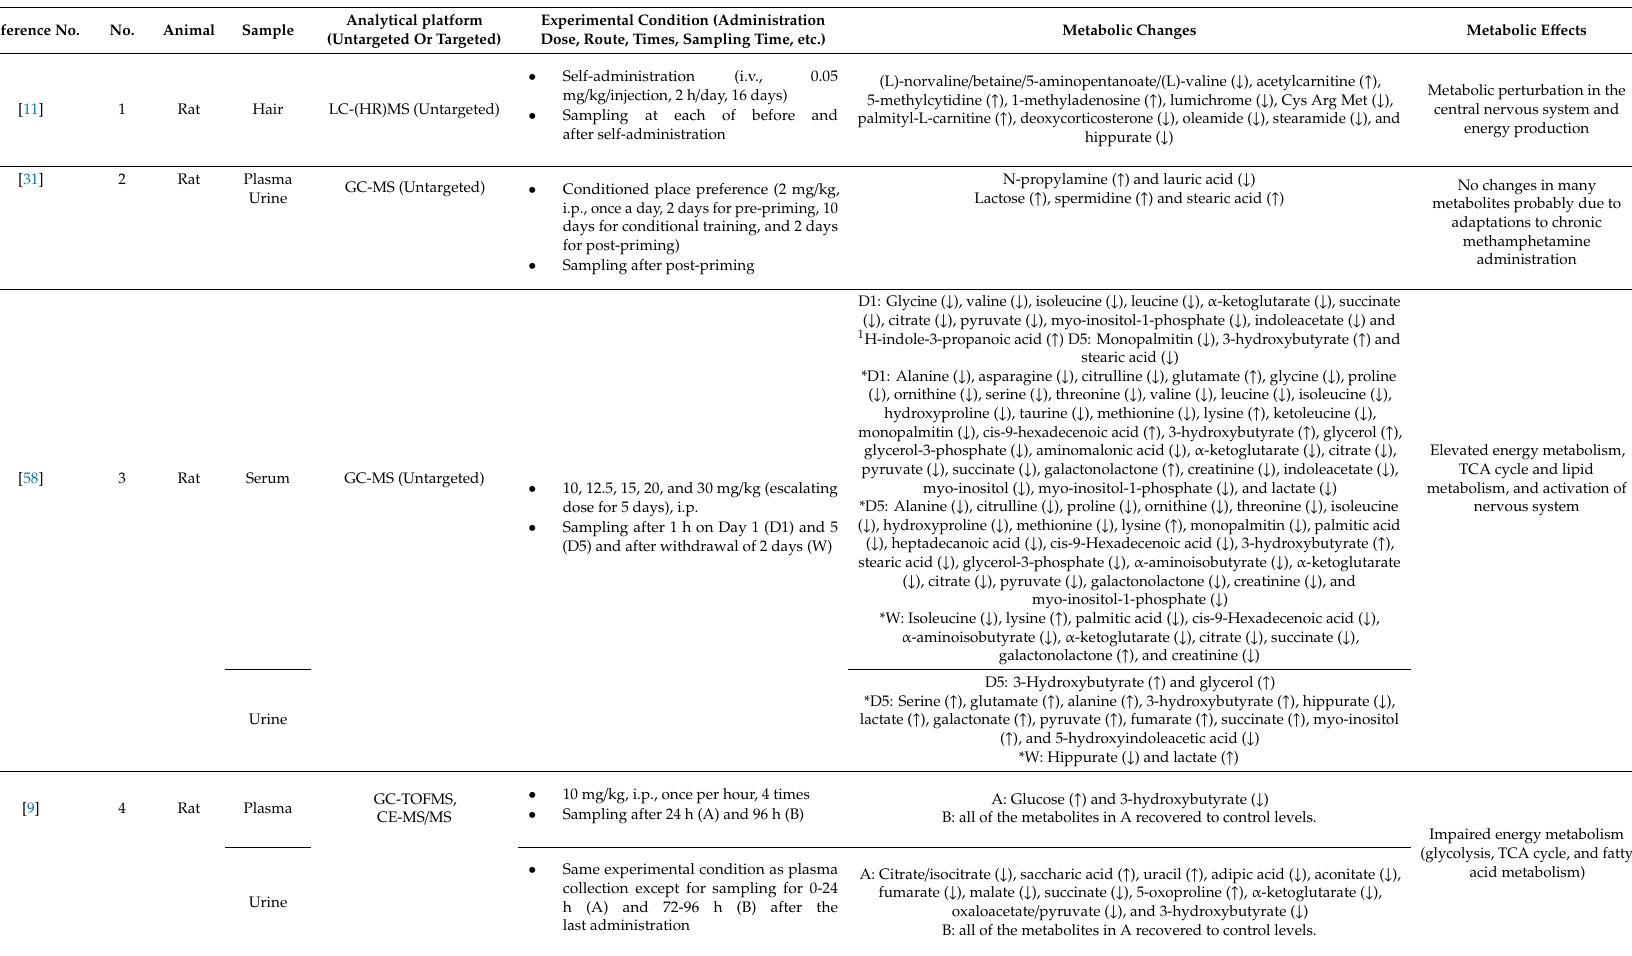
oxaloacetate / pyruvate ( ↓ ), and 3-hydroxybutyrate ( ↓ ) B: all of the metabolites in A recovered to control levels.